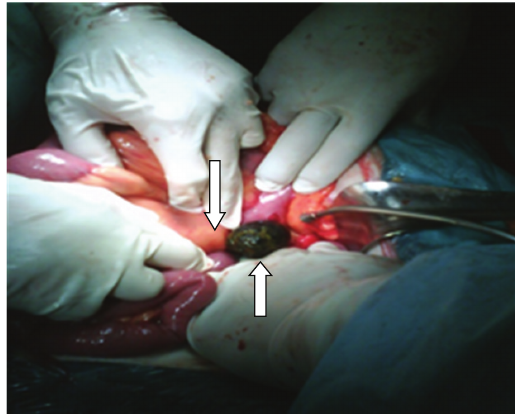
Figure 12: The extraction of the gallstone right after the ligament of Treitz